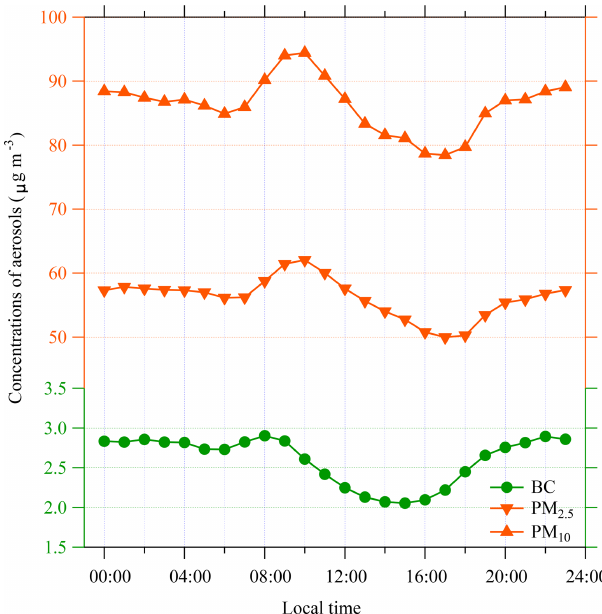
Figure 3. The 6-month mean diurnal variations of BC, PM 2 . 5 , and PM 10 at the Gulou site from September 2016 to February 2017.